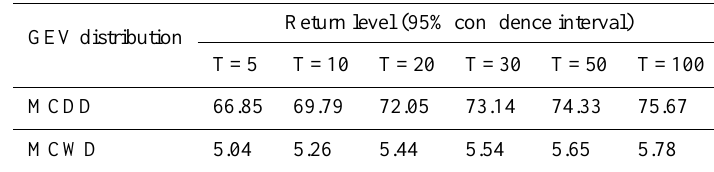
Fig. 5b, which are arranged by longitude-latitude. Highest mean annual values are found at stations in the